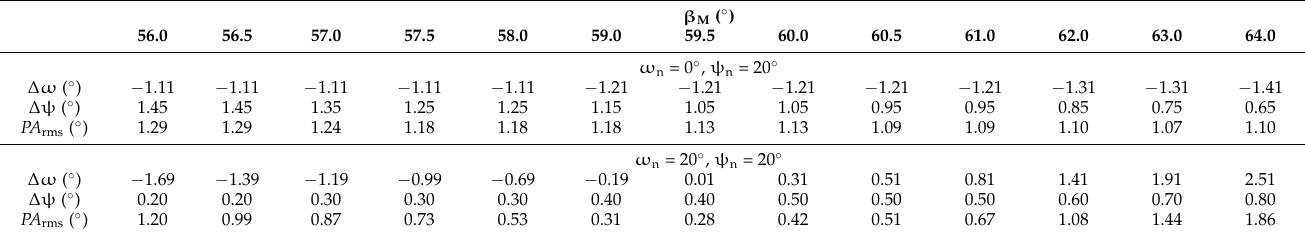
Table 10. Optimization of the model opening